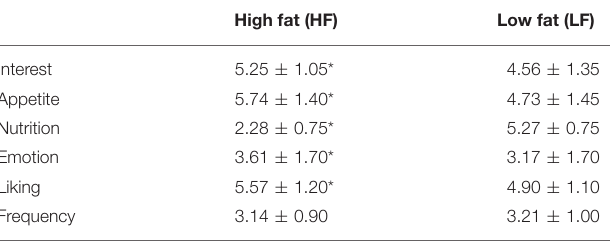
TABLE 2 | Means and standard deviation of image ratings collapsed into high fat and low fat categories.